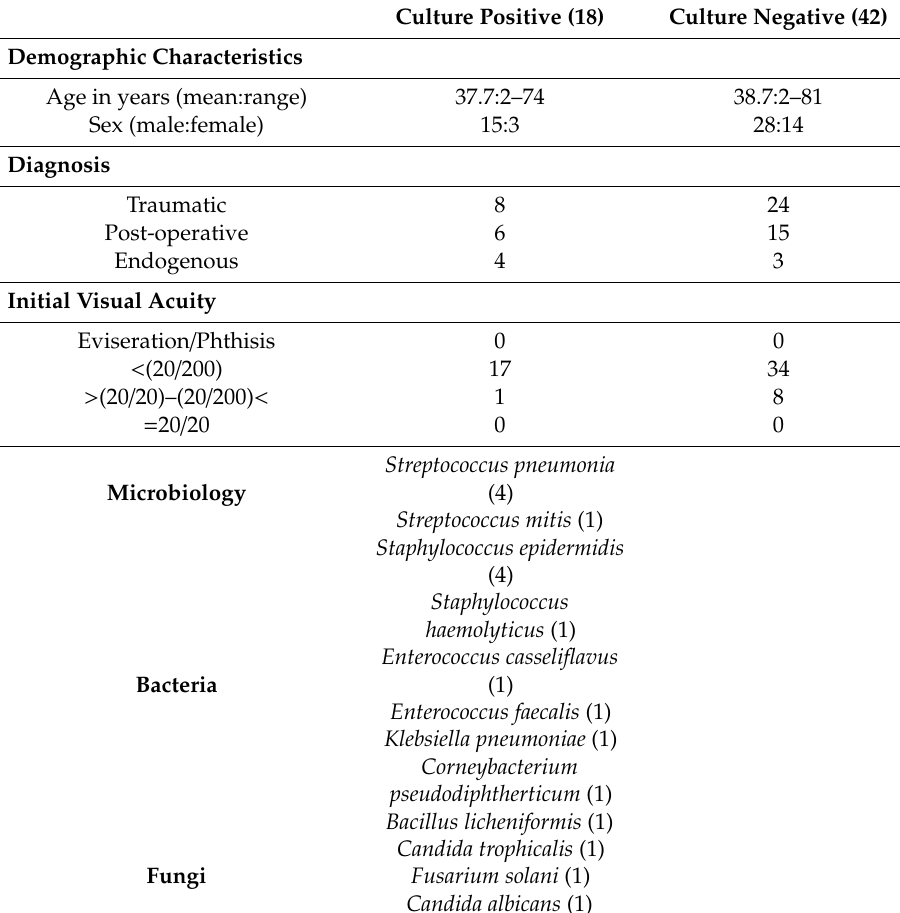
Table 1. Clinical and microbiological details of the study patients diagnosed clinically as infectious